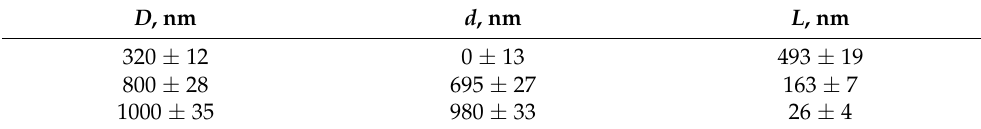
Figure 1. Schematic representation of a pore in a SiO 2 /Si template (upper diameter D , lower diameter d , and thickness of silicon oxide layer L ).